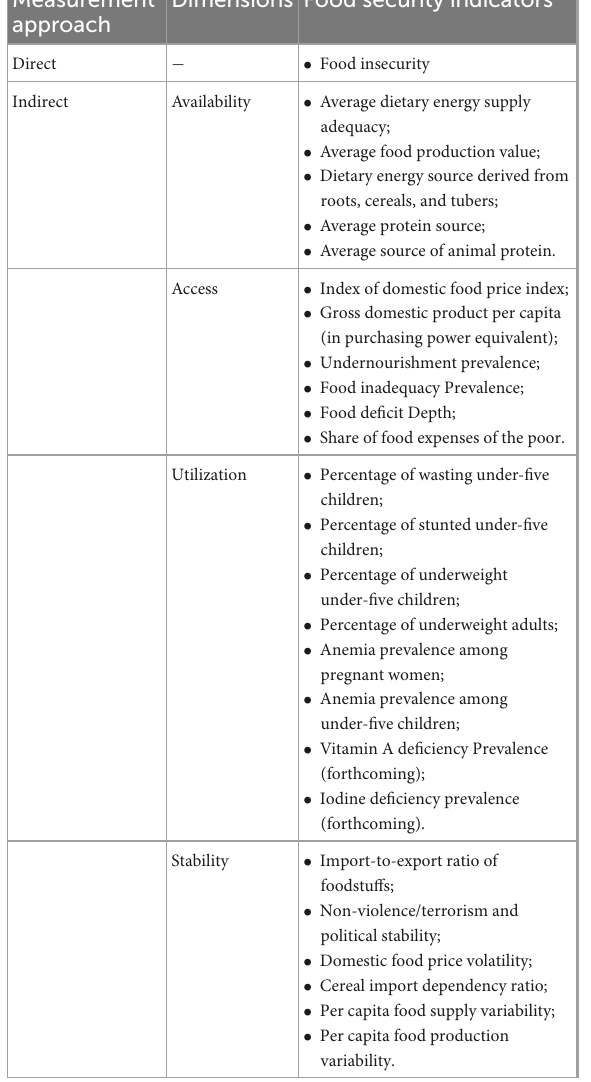
TABLE 2 Indicators of food security as primary outcomes of community-based participatory interventions to improve food security in developing